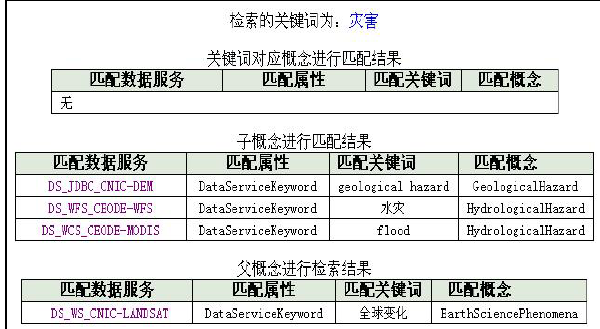
Figure 7. The search results of spatial data